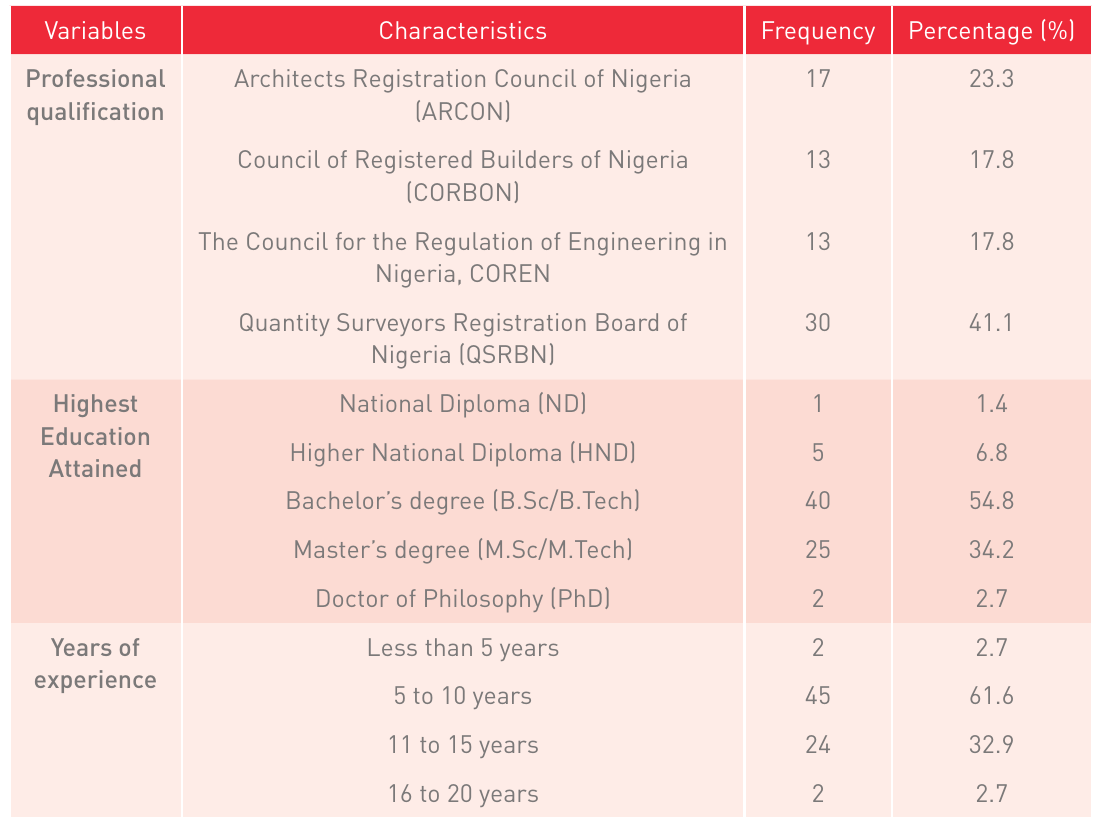
Demographic characteristics of the